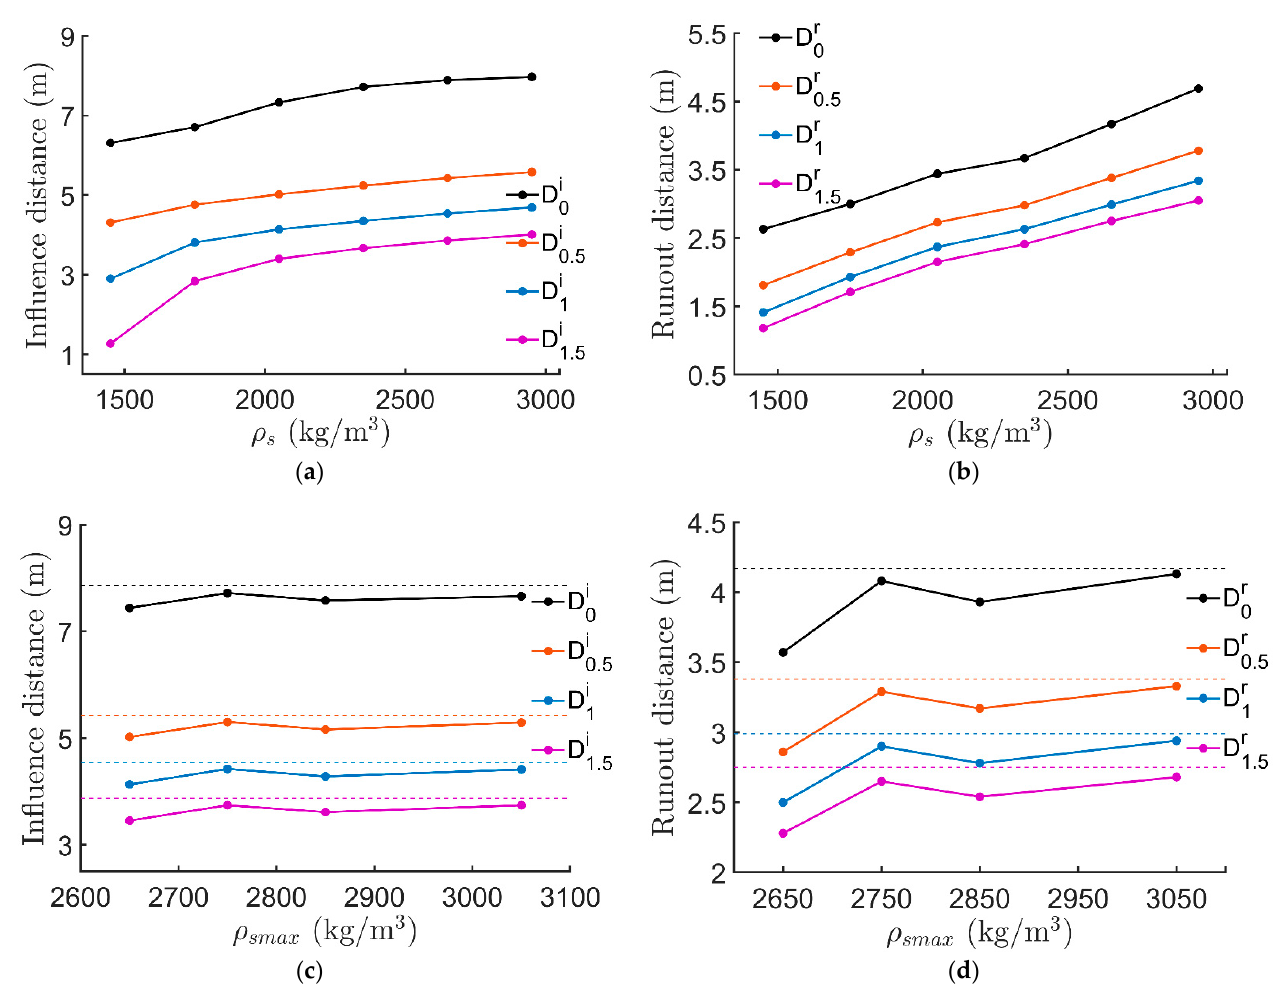
Figure 14. Variations in influence distance and runout with different densities: ( a ) different influence distances in uniform slopes; ( b ) different runout distances in uniform slopes; ( c ) different influence distances in layered slopes; ( d ) different runout distances in layered slopes.